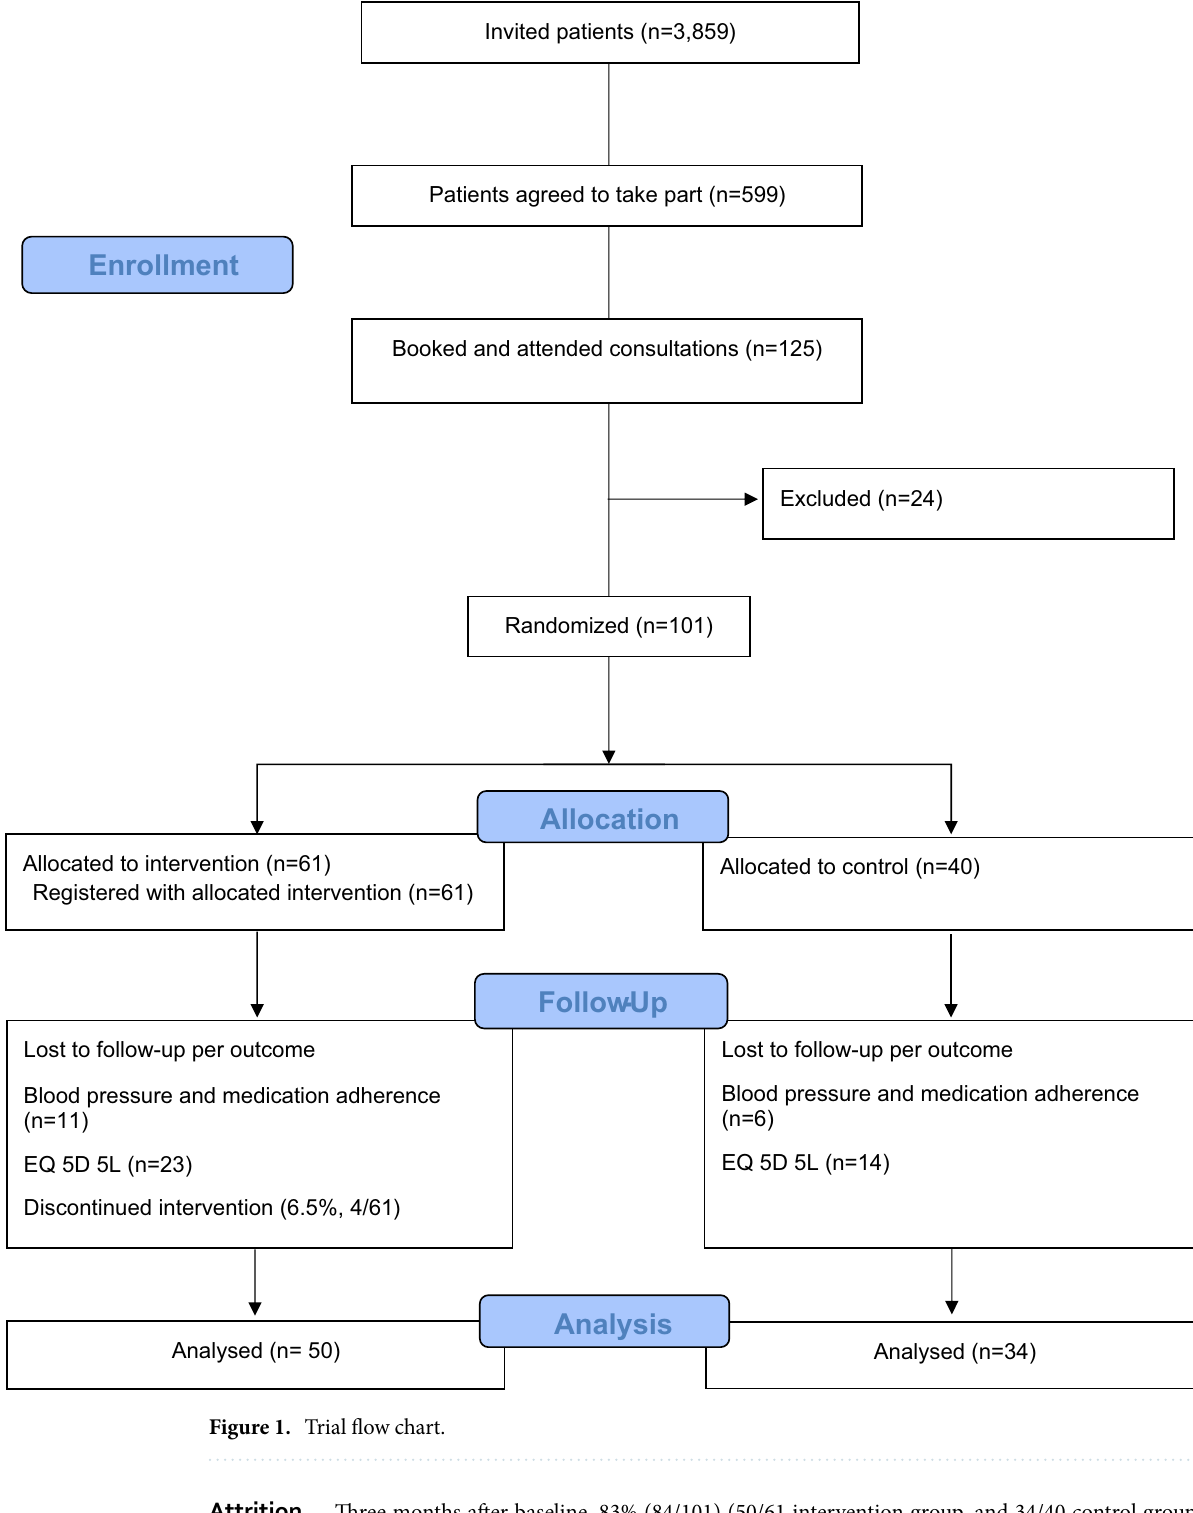
Figure 1. Trial flow